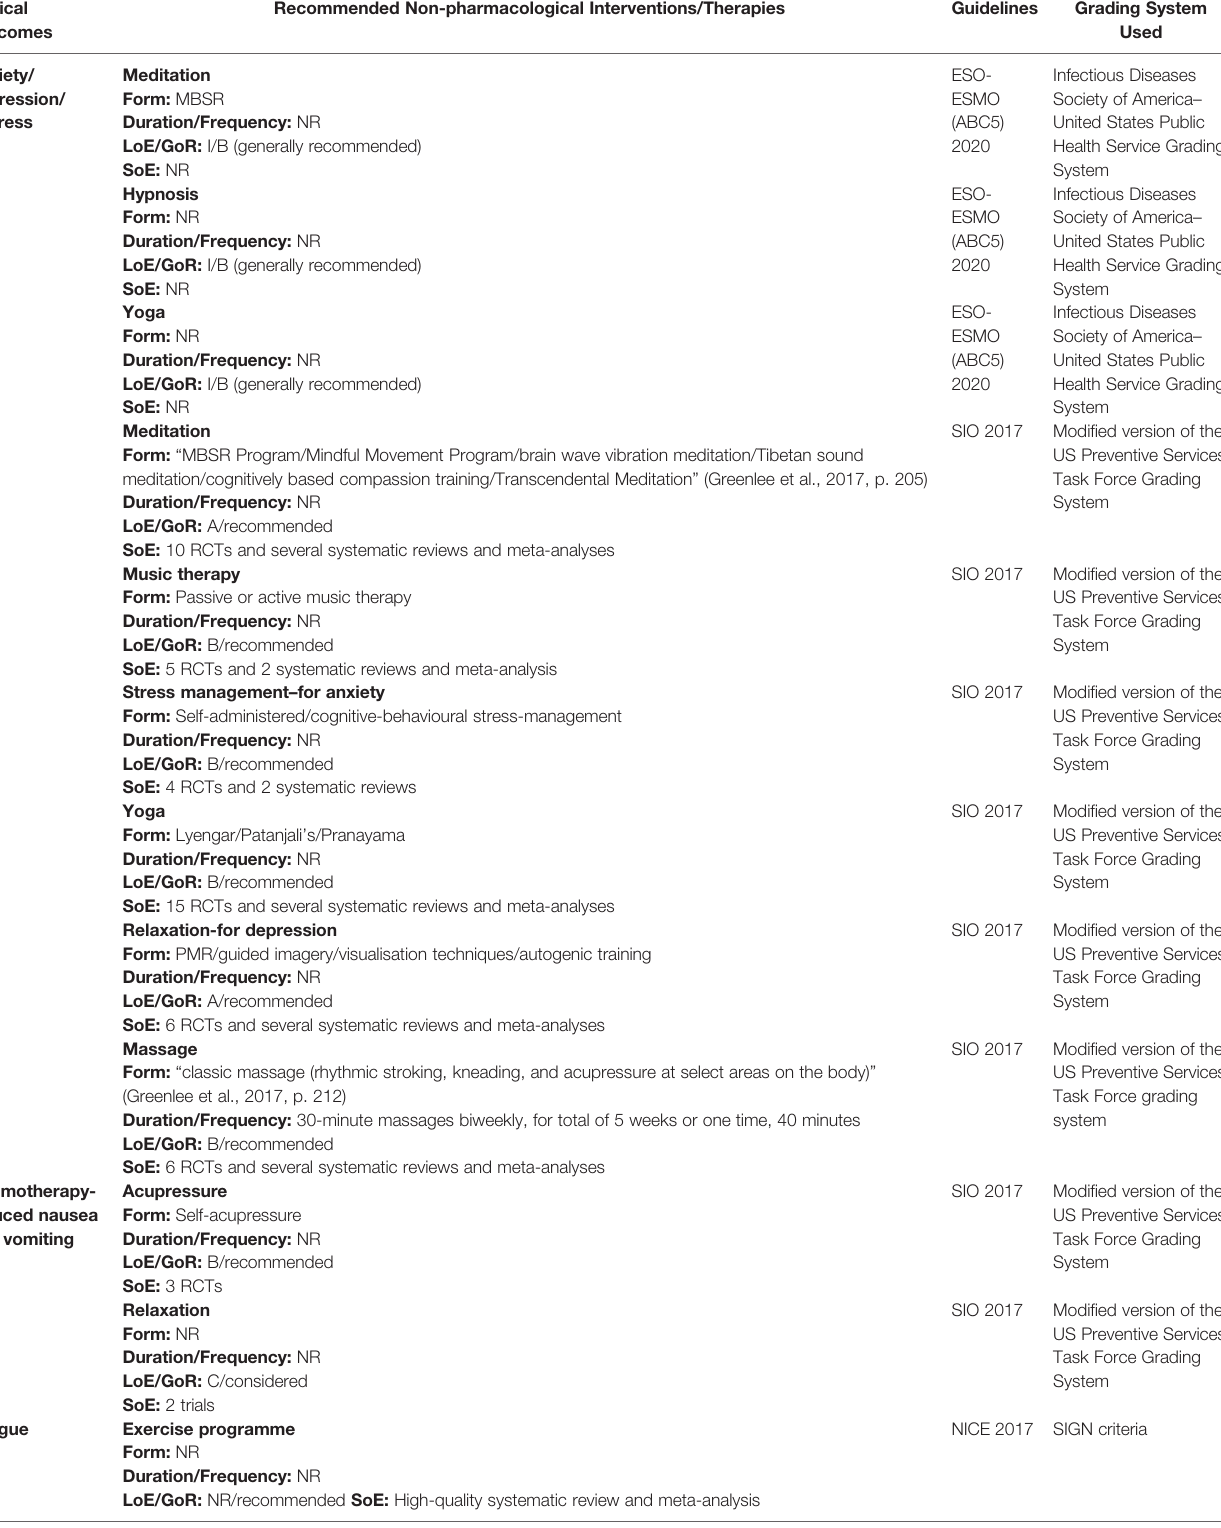
TABLE 4 | Non-pharmacological interventions and therapies recommended by the included clinical practice guidelines. Clinical Recommended Non-pharmacological Interventions/Therapies Outcomes